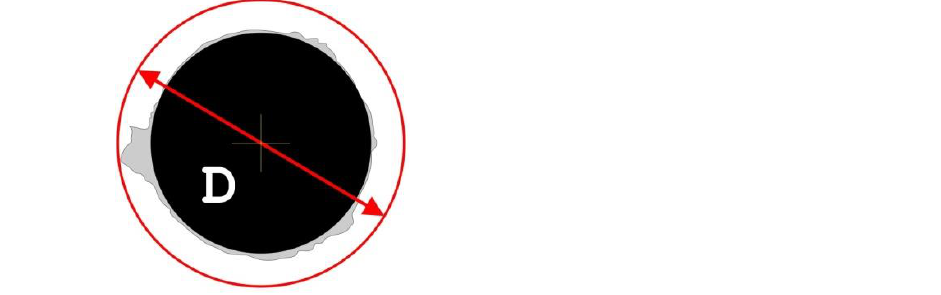
Figure 3. The characteristic diameters D determined on both sides of the boards during the machining quality testing.